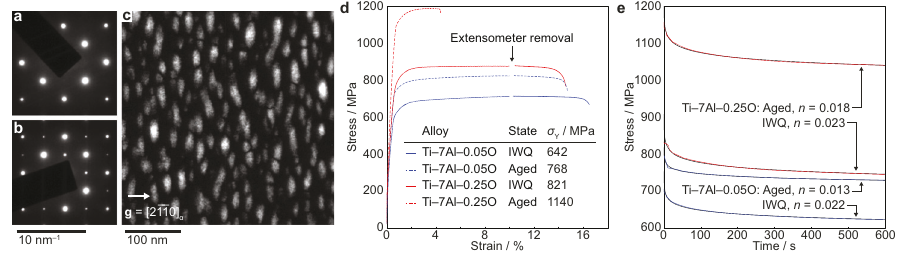
Fig. 1 | TEM and mechanical characterisation of the Ti – 7Al – O model alloys. Selected areaelectron diffraction patterns( B = ½ 0111 (cid:2) )forthe( a )quenchedand ( b ) aged conditions show the appearance of superlattice re fl ections from the α 2 pre- cipitates, shown in ( c ) for Ti – 7Al – 0.25O (dark fi eld, B = ½ 0111 (cid:2) , g = ½ 2110 (cid:2) two-beam condition). Macroscopic mechanical responses and microstructure of Ti – 7Al –